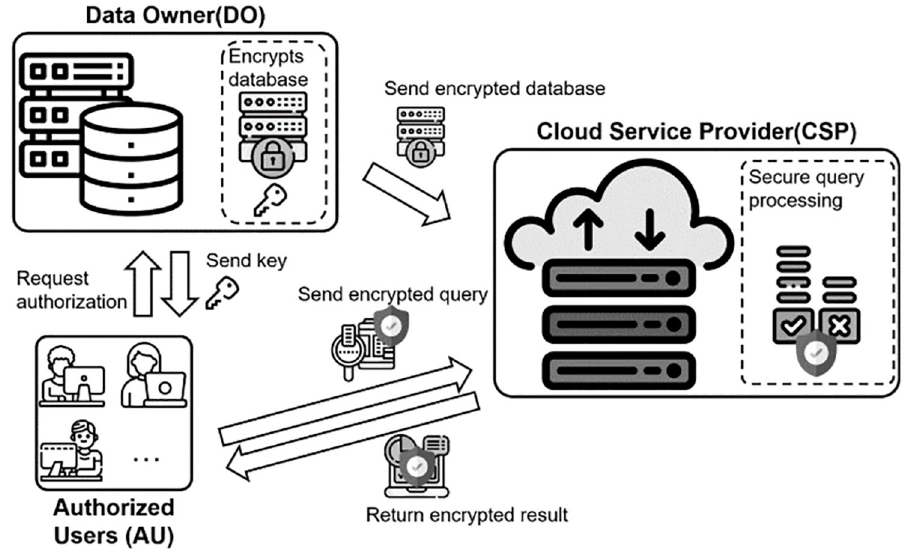
Fig 1. Database outsourcing